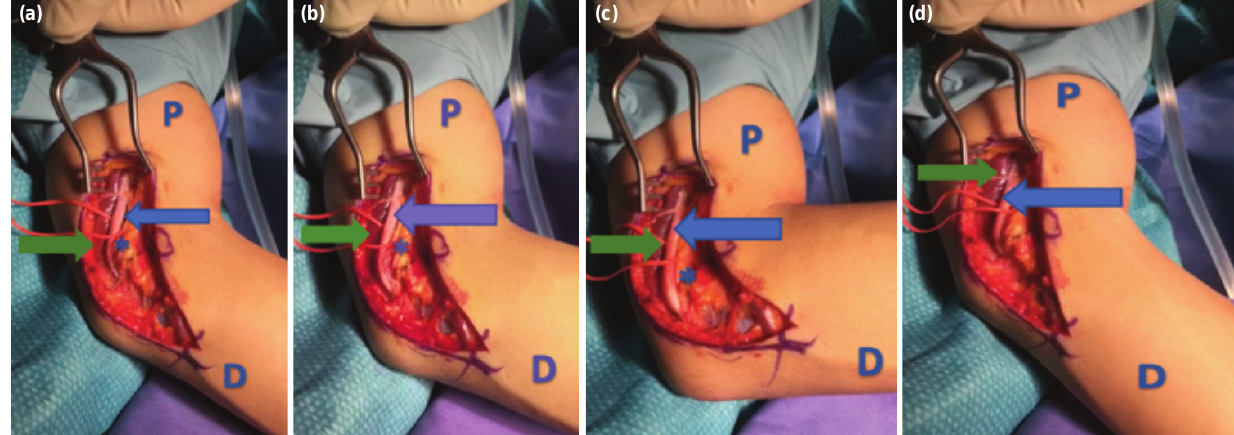
Subluxation of the Ulnar Nerve pre fixation during elbow flexion. (a) The elbow at 30° flexion. (b) The elbow at 70° flexion. (c) Fig. 1: The elbow at 90° flexion. (d) Back to 30° elbow flexion. (Blue arrow: represent the ulnar nerve, Green arrow: the triceps medial head, and asterisks: the medial epicondyle. D: distal, P: proximal).